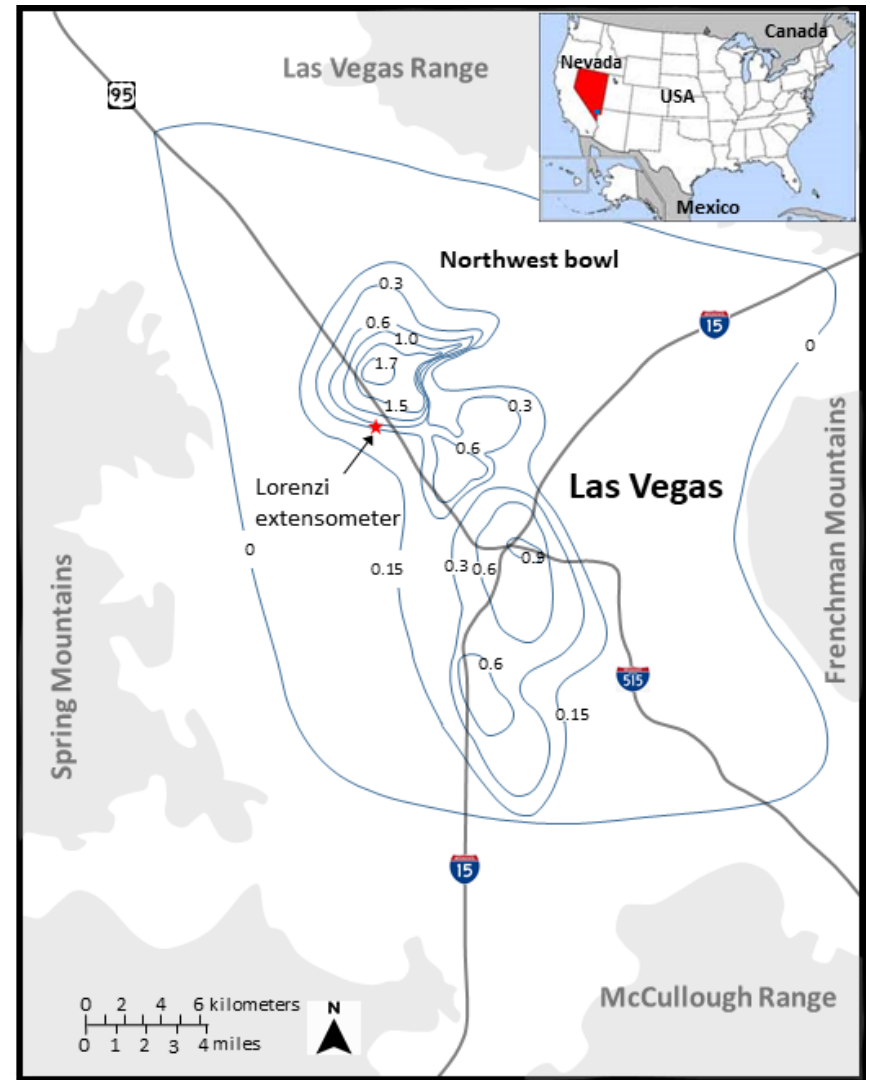
Figure 1. Map of Las Vegas Valley showing the location of the Lorenzi extensometer site and estimated and measured land subsidence for the period 1963–1990 adapted from Bell et al.